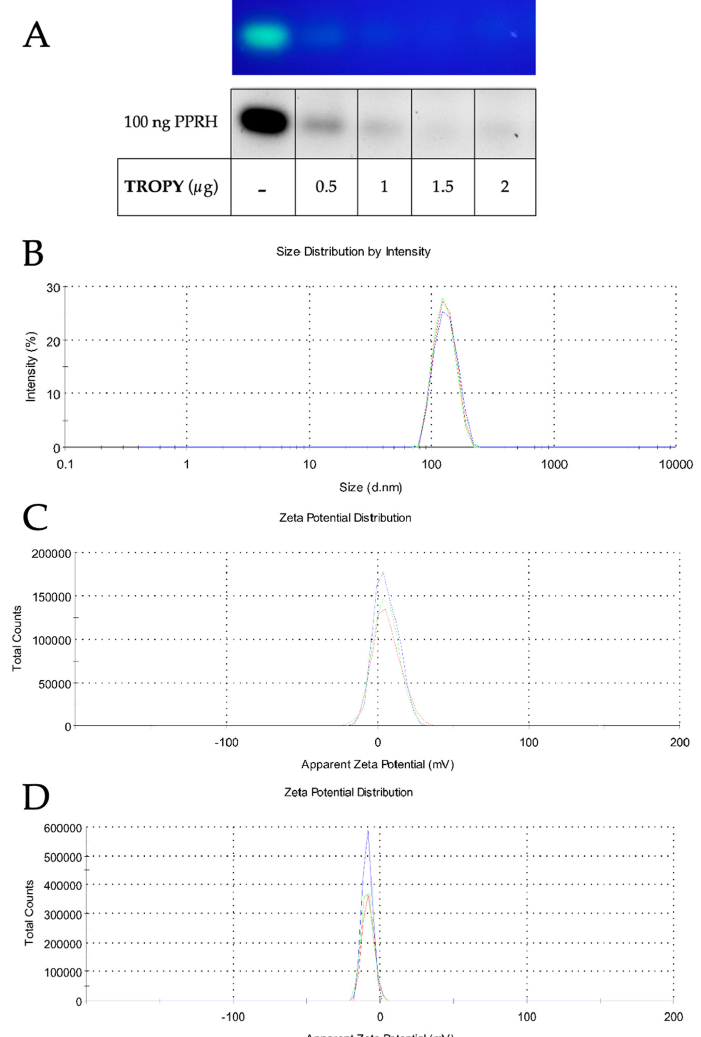
Figure 3. Characterization of the complex formed between PPRH and TROPY. ( A ) The binding capacity of TROPY was determined using 100 ng of a FAM-labeled PPRH incubated with the indicated amounts of the transfection agent. The mixture was carried out in PBS 1X for 20 min in a final volume of 10 µ L, to which was then added 2 µ L of 6 × sample buffer, and the mixture was resolved electrophoretically in 0.8% agarose gels. Bands were visualized under UV light in a Bio-Rad Gel Doc EZ TM Imager. The bands are shown both as fluorescent and in black and white. The image shown is representative of three electrophoreses. ( B ) The size of the complex was determined by DLS using 1.25 µ g/mL of TROPY incubated with 100 nM PPRH. ( C ) The charge of TROPY alone and ( D ) TROPY–PPRH complexes were determined by Doppler microelectrophoresis using 1.5 µ g/mL of TROPY with 100 nM PPRH. Determinations are the mean ± SE of three experiments. The 3 peaks with colours represent each one of the 3 measurements of the triplicate